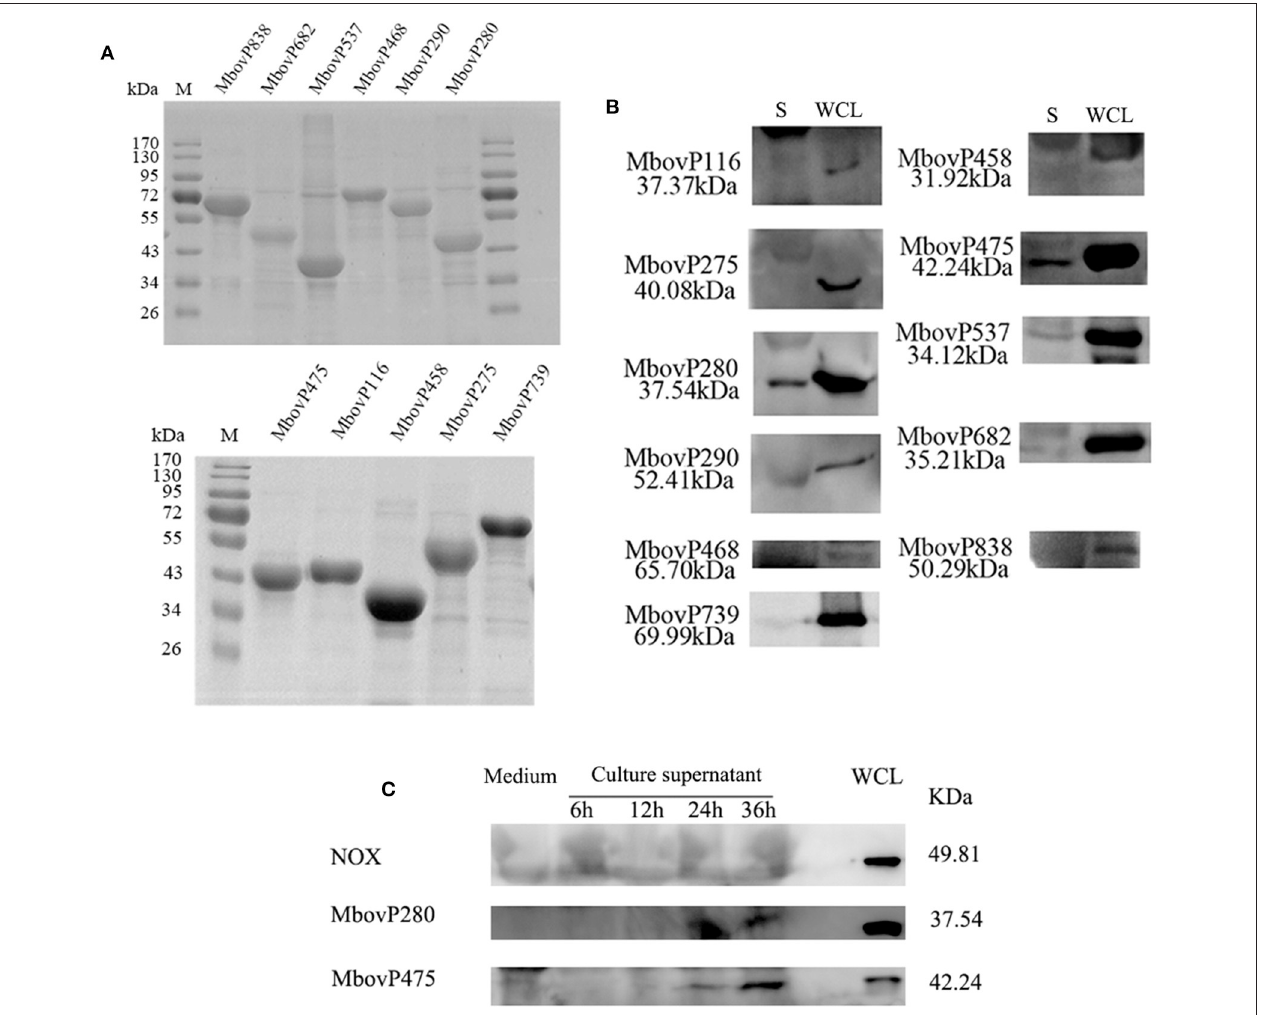
FIGURE 1 | Secretion of MbovP280. (A) Purification of 11 predicted secreted proteins. The proteins were purified with nickel affinity chromatography and resolved with SDS-PAGE. (B) Confirmation of the predicted secreted proteins with western blotting assays. Secretome (S) and whole-cell lysate (WCL) of M. bovis were resolved with SDS-PAGE and transferred onto polyvinylidene difluoride membranes. Polyclonal antibodies directed against rMbovP280, rMbovP290, rMbovP475, rMbovP468, rMbovP838, rMbovP537, rMbovP458, rMbovP682, rMbovP116, rMbovP275, and rMbovP739 were used to detect the proteins in the secretome. (C) Visualization of the secreted MbvoP280 in culture supernatant. M. bovis HB0801 was cultured in PPLO medium. The culture supernatant was collected and concentrated at 6, 12, 24, and 36h after incubation. The antiserum against rMbovP280 and rMbovP475 were used to detect the proteins in the supernatant, while M. bovis NOX known as the membrane-associated protein served as the negative control